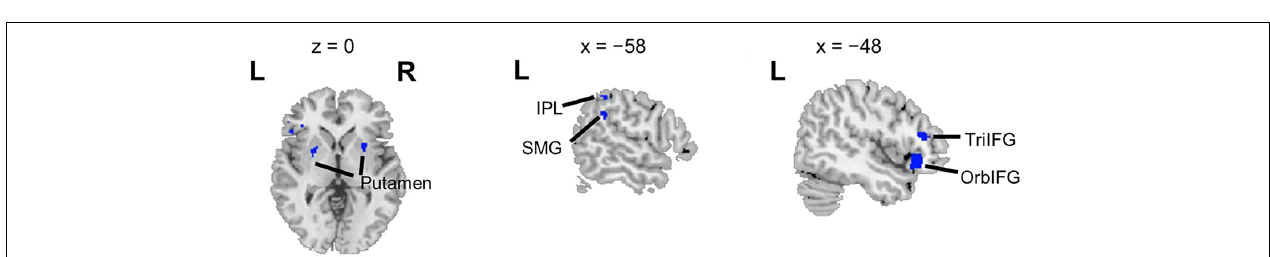
FIGURE 4 | Overlapping brain areas activated by both the ASP effect and the spatial unmasking effect. L, left; R, right. Negative values of the x axis (the coronal axis) denote the left hemisphere. The variable z denotes the vertical axis.